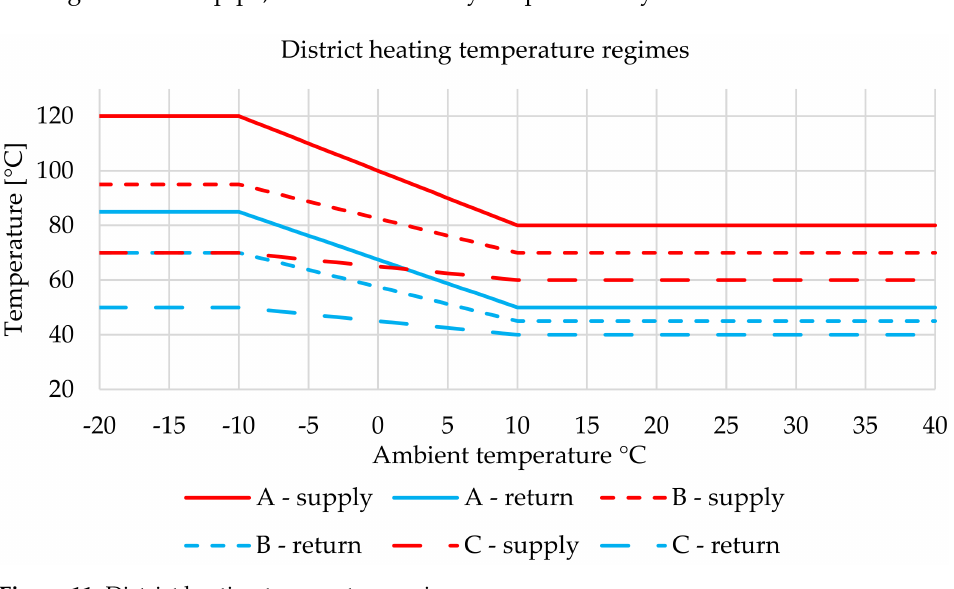
Figure 11. District heating temperature regimes. Table 4. Input data for district heating connection